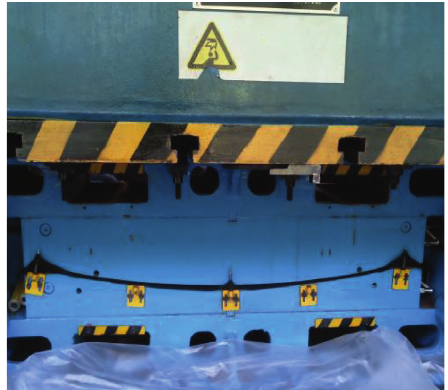
Figure 12: Raw material molding.